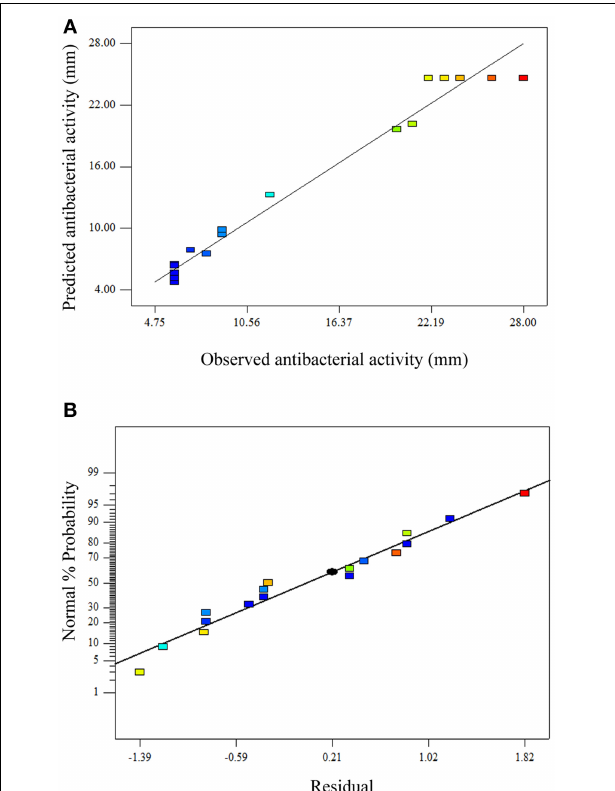
FIGURE 6 | Diagnostic plots showing the model adequacy. (A) Plot of observed response vs. predicted reponse and (B) normal probability plot of the studentized residuals.